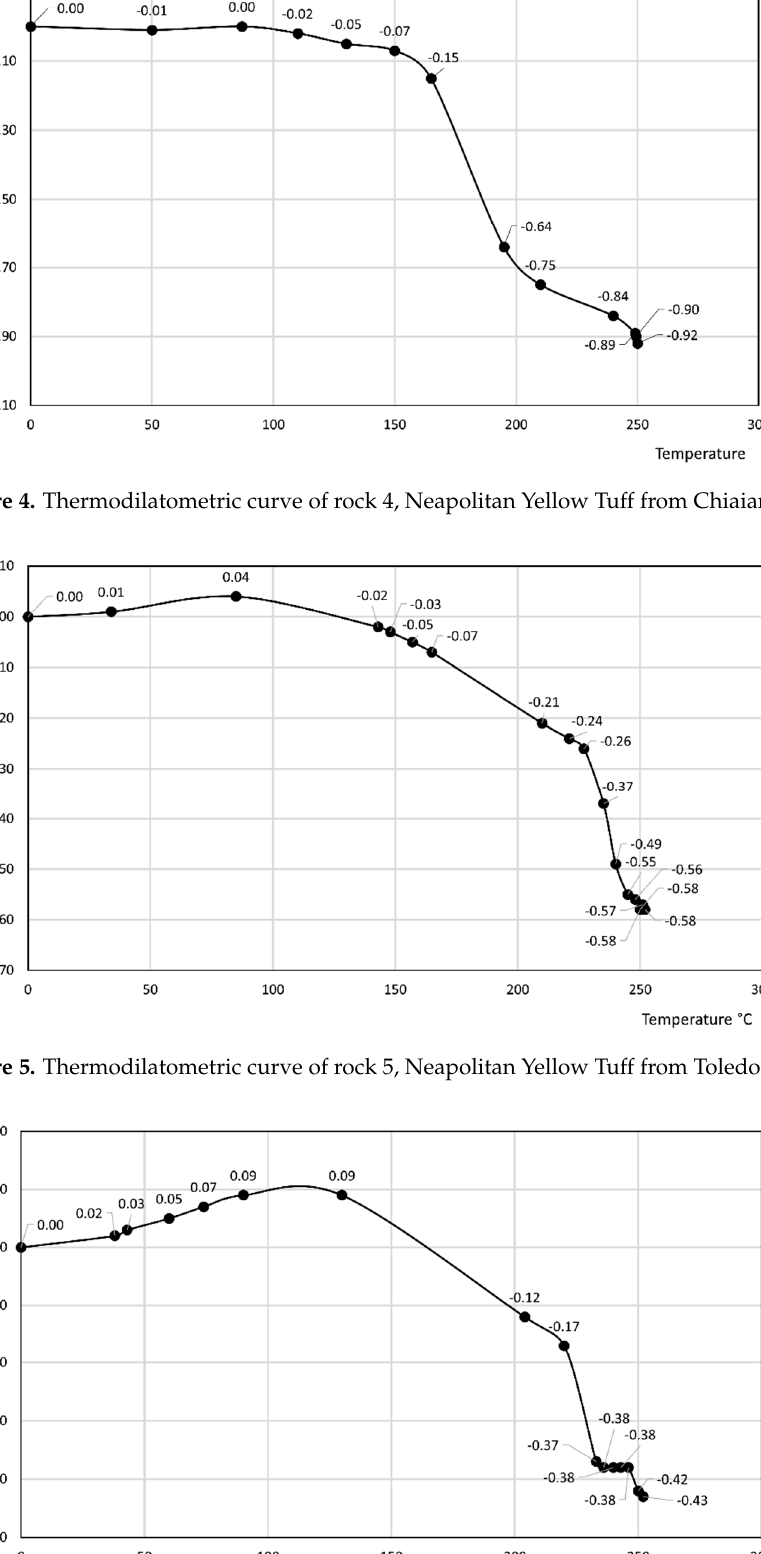
Figure 6. Thermodilatometric curve of rock 6, Sardinian Epiclastite from Anela. The thermodilatometric curve of the Campanian Ignimbrite from Faicchio (rock 7,